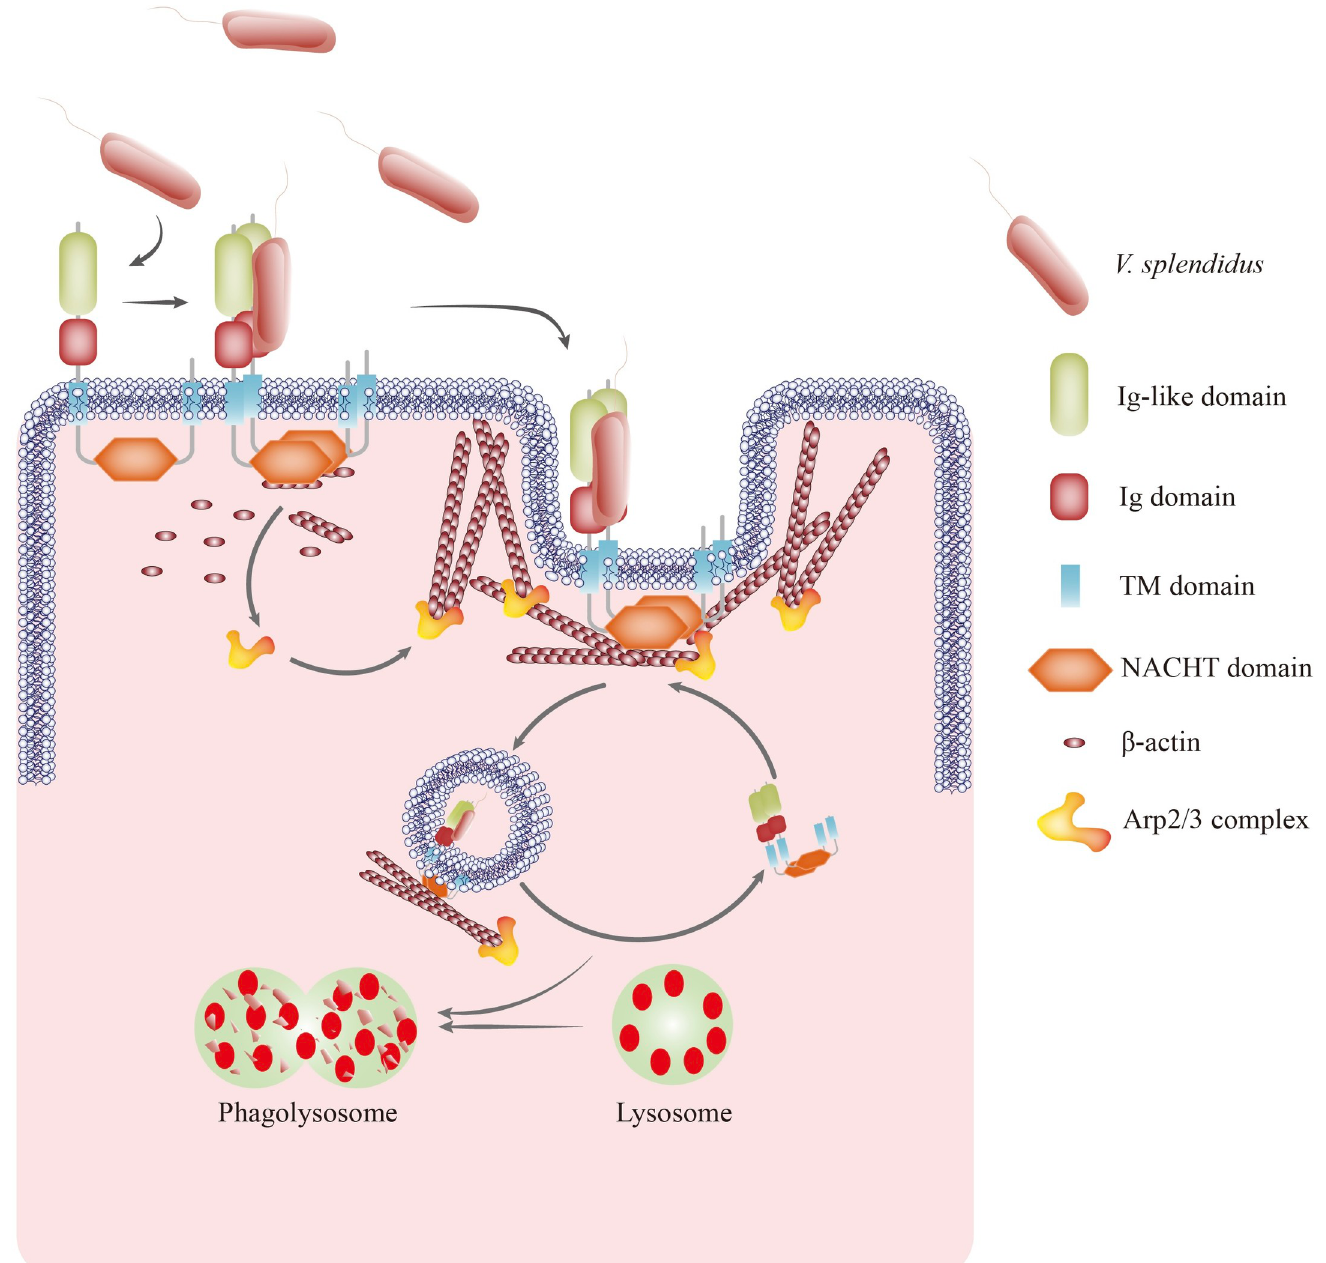
Fig 10. Schematic of the role of AjNLRC4 in promoting V . splendidus endocytosis as a transmembrane receptor. V . splendidus binds to the extracellular domains of AjNLRC4 and activates receptor-mediated endocytosis. AjNLRC4 oligomerizes, and the intracellular domain of AjNLRC4 interacts with Aj β -Actin, forming a protein complex that facilitates V . splendidus internalization through the actin-mediated endocytosis pathway by Arp2/3 complex-mediated cytoskeleton polymerization and rearrangement. Finally, V . splendidus is degraded in coelomocyte phagolysosomes, which effectively restricts V . splendidus infection in sea